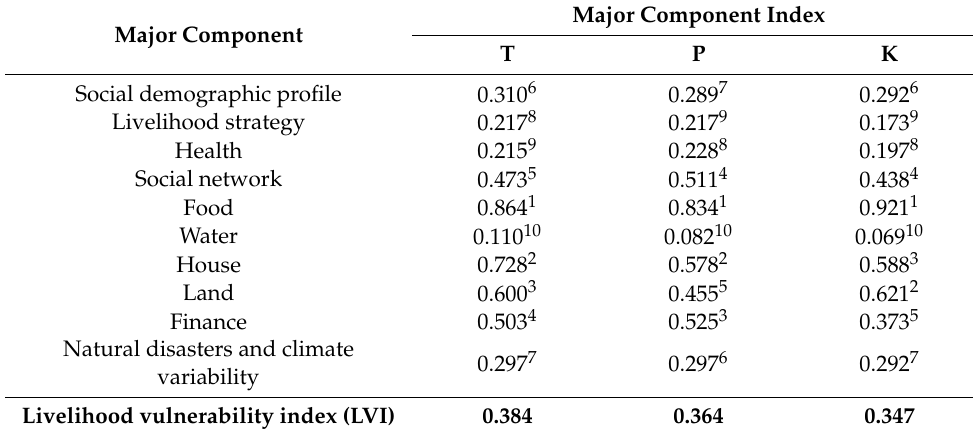
regions in Pahang,